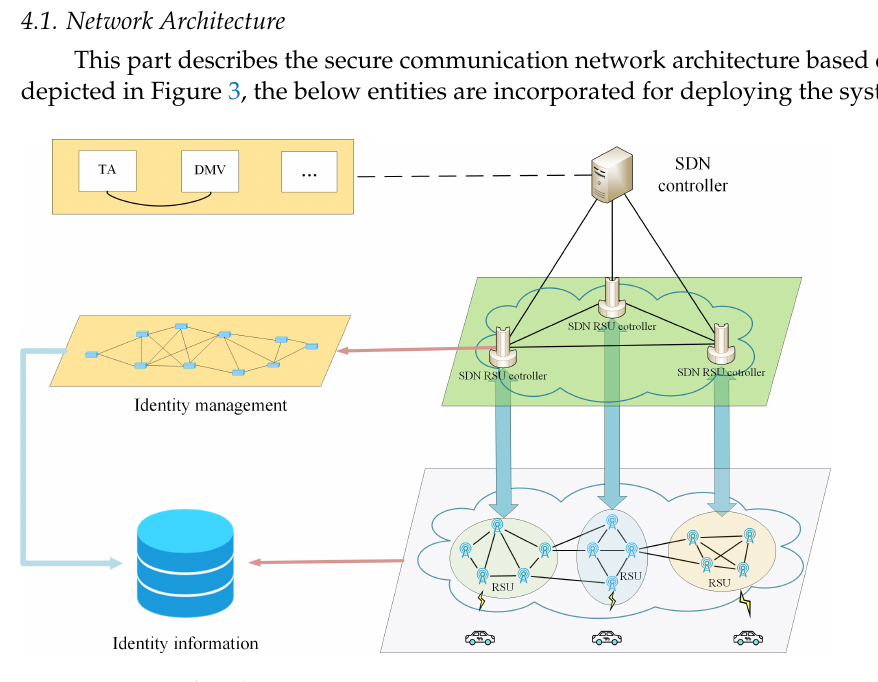
Figure 3. Network